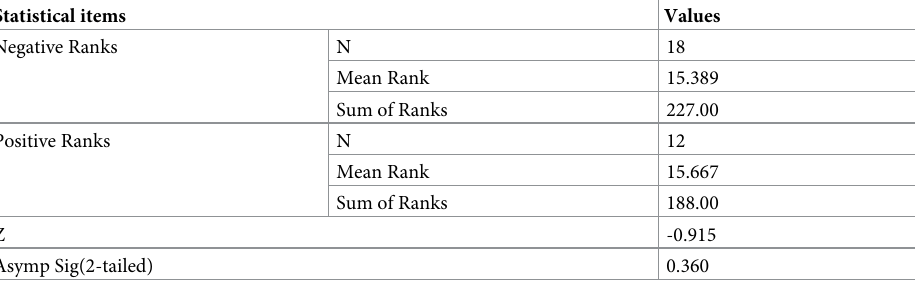
Table 9. Wilconxon Signed Ranks test for through at the CFI approach.